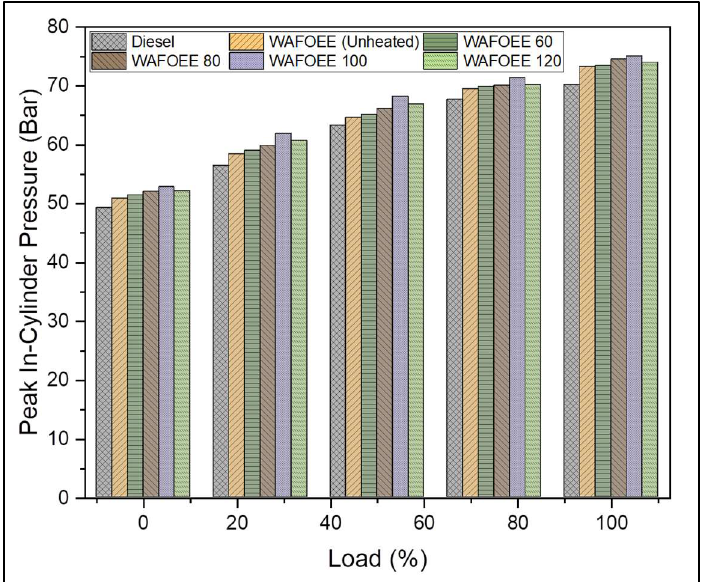
Figure 6. Peak in-cylinder pressure of neat diesel and biodiesel samples for varying engine loads.